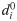
Im9 potential energies by interaction type.Average native (red) and nonnative (blue) Lennard Jones (filled) and electrostatic (hashed) energies are shown for (A) H1→H2 restrained at displacement di0 = 1.10 nm and (B) H1→H2LH3LH4C at di0 = 1.04 nm. The notation for energy types is identical to that in Fig 4. Component energies shown here are for the interactions within H1, H2, or H2LH3LH4C; solvent-helix interactions (S-H1, S-H2, S-H2LH3LH4C); direct helix-helix interactions (H1-H2, H1-H2LH3LH4C); solvent-solvent interactions (S-S); and the sum of all component energies.